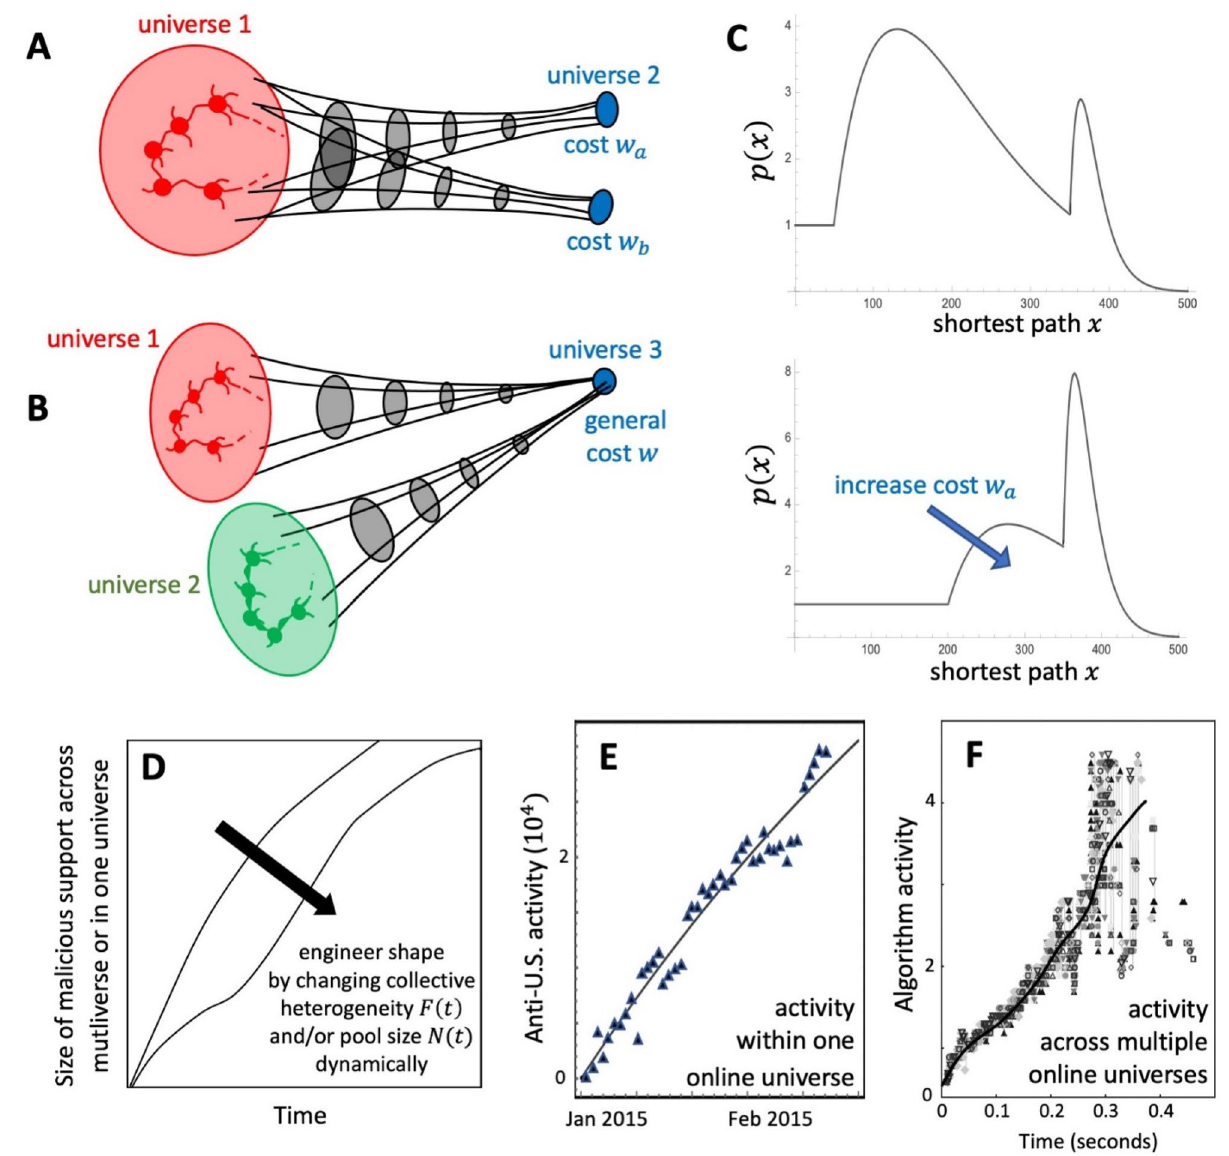
Figure 4. Link engineering to mitigate spreading. Details of each panel are discussed in the text with full mathematical derivations of all the predictions and results given in the Supplementary